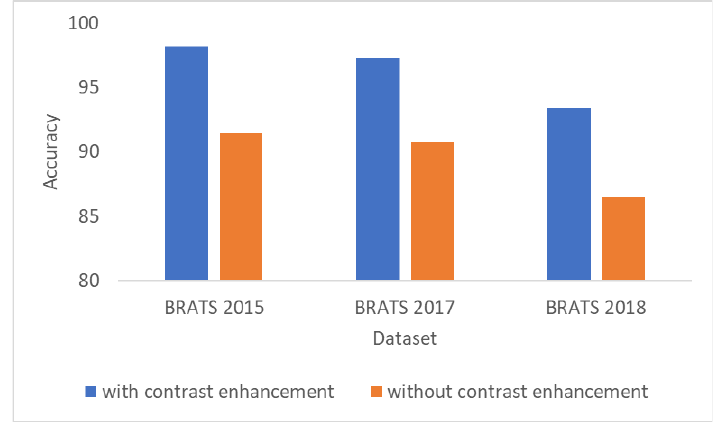
Figure 7. Accuracy results with and without employing the contrast enhancement step.